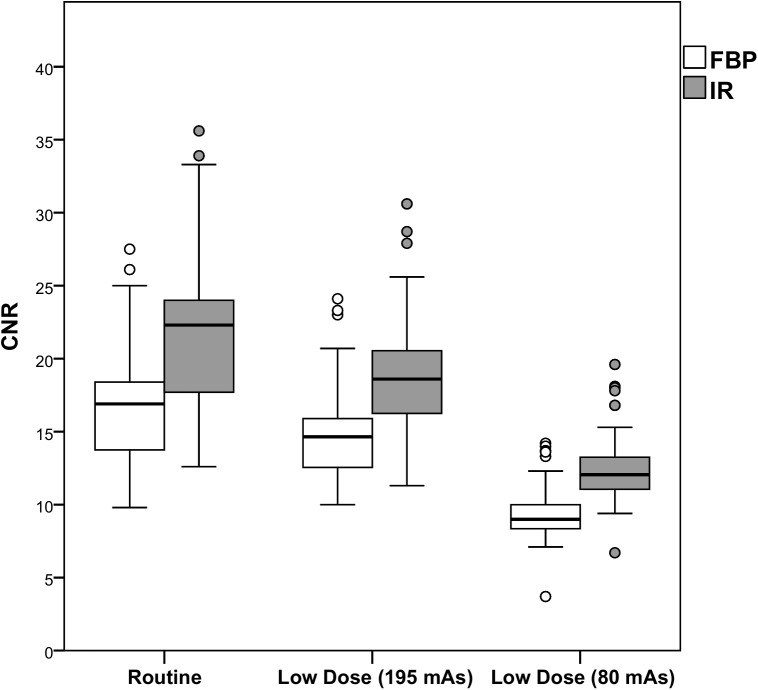
CNR per dose level for FBP and IR.The white boxes represent the CNR with FBP, while the gray boxes represent the CNR with IR. IR resulted in an increase in CNR compared to FBP at the same dose level. CNR Contrast-to-noise ratio, FBP Filtered Back Projection, IR Iterative Reconstruction